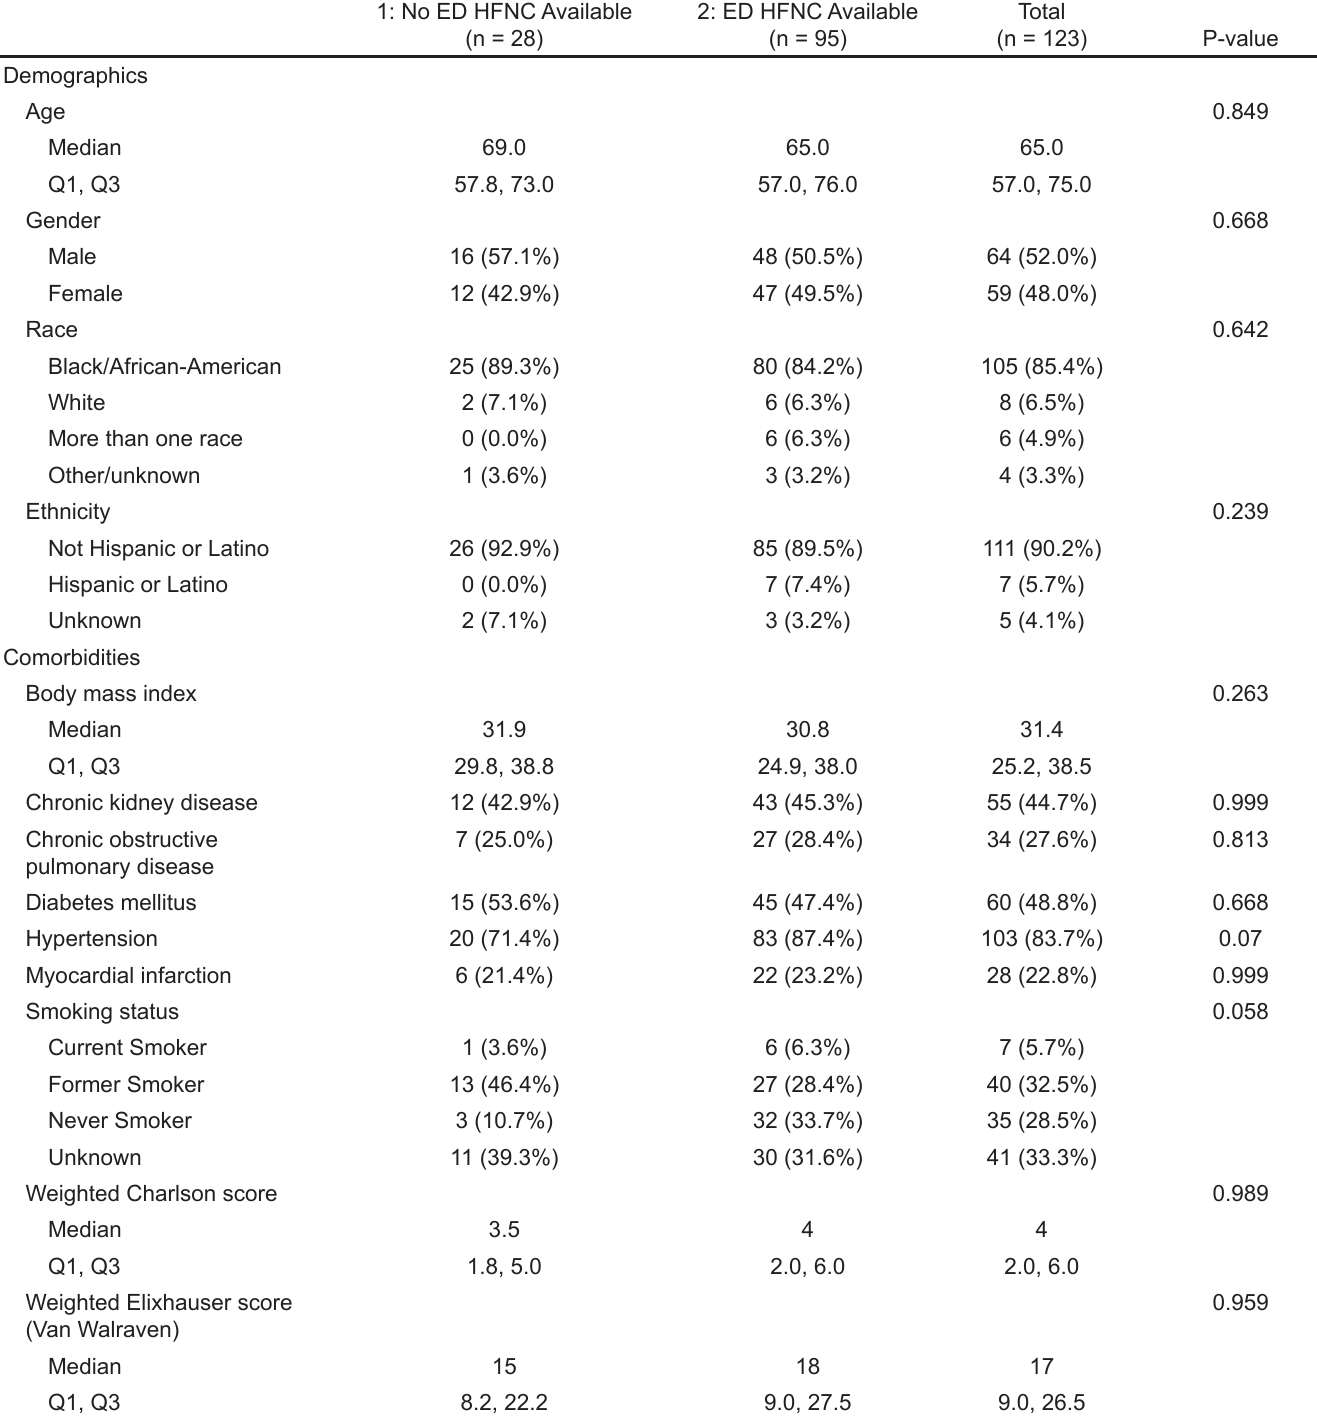
Table 1. Characteristics COVID-19-positive patients seen in the emergency department (ED) before and after the availability of high- flow nasal cannula in the